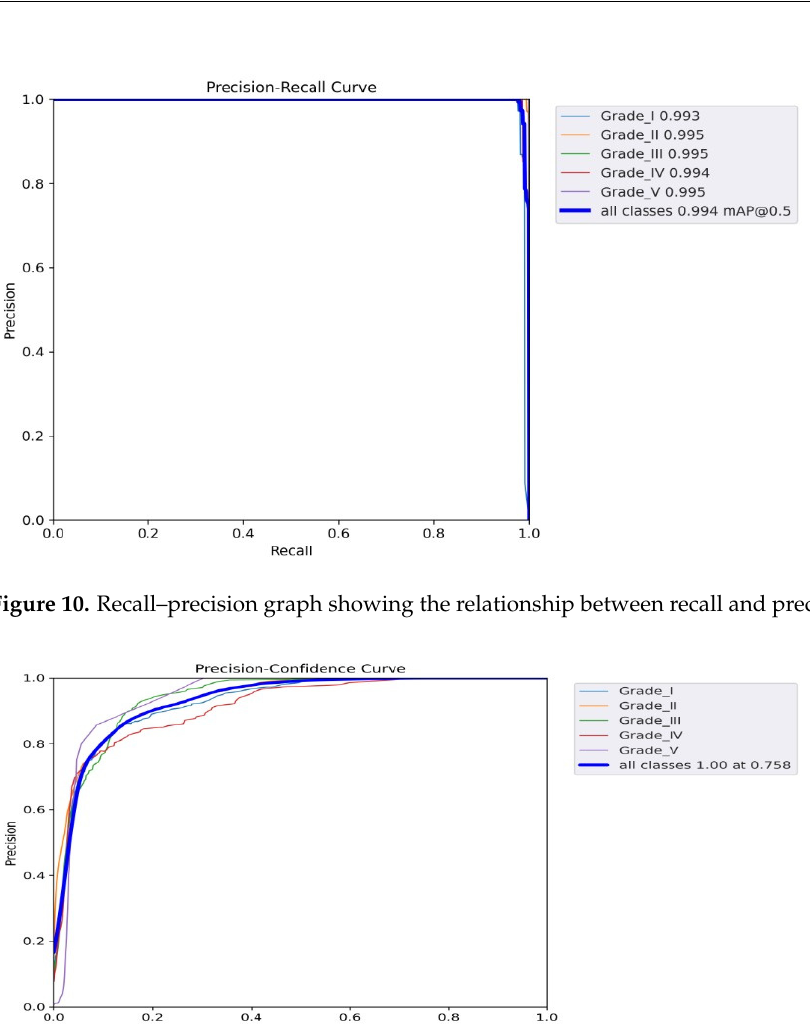
Figure 9. F1 score graph showing the relationship between F1 and the confidence curve.